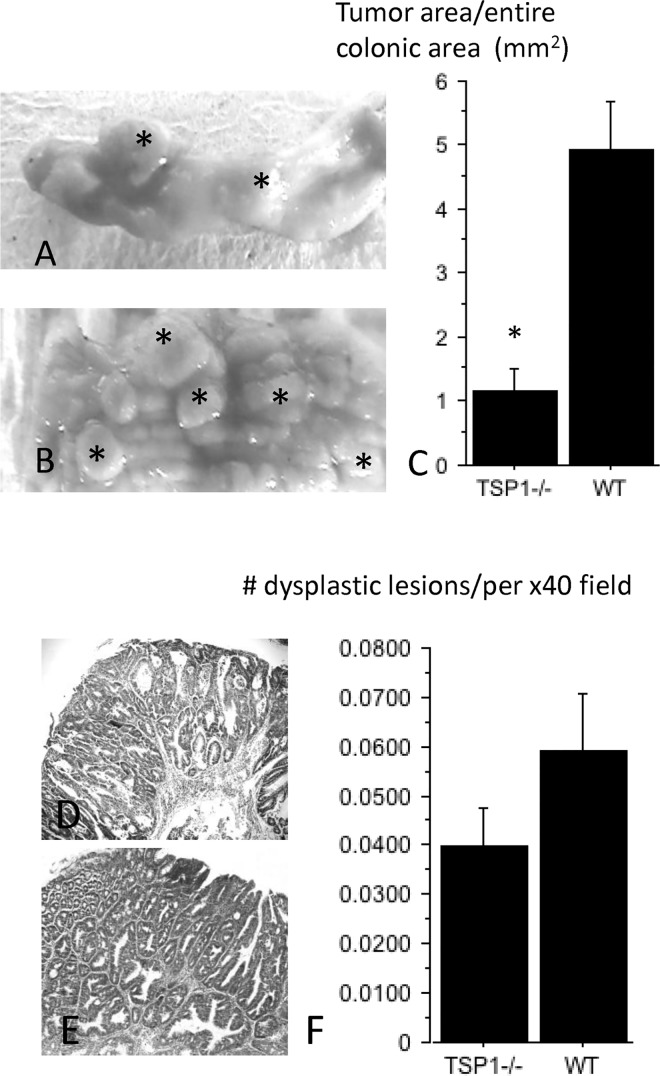
Gross and microscopic features of AOM/DSS tumors originated in WT and TSP-1-/- colons.Tumors in TSP-1-/- colons (A, asterisks) consisted of well-delimited polypoid lesions separated by wide areas of normal mucosa. WT tumors (B, asterisks) were grossly characterized by multiple coalescing tumors delimited by little intervening normal mucosa When the area containing tumors was compared with the entire colonic area of each mouse, the tumor burden was decreased in AOM/DSS-treated TSP-1-/- versus WT mice (p = 0.0060), (C). All the microscopic dysplastic foci were analyzed in TSP-1-/- (D) and WT colonic sections (E). No significant differences were observed in the number of dysplasic lesions detected by microscopic field (p = 0.14) (F).